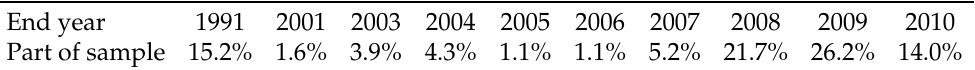
Table 6. Fraction of the M4 annual data with the specified year